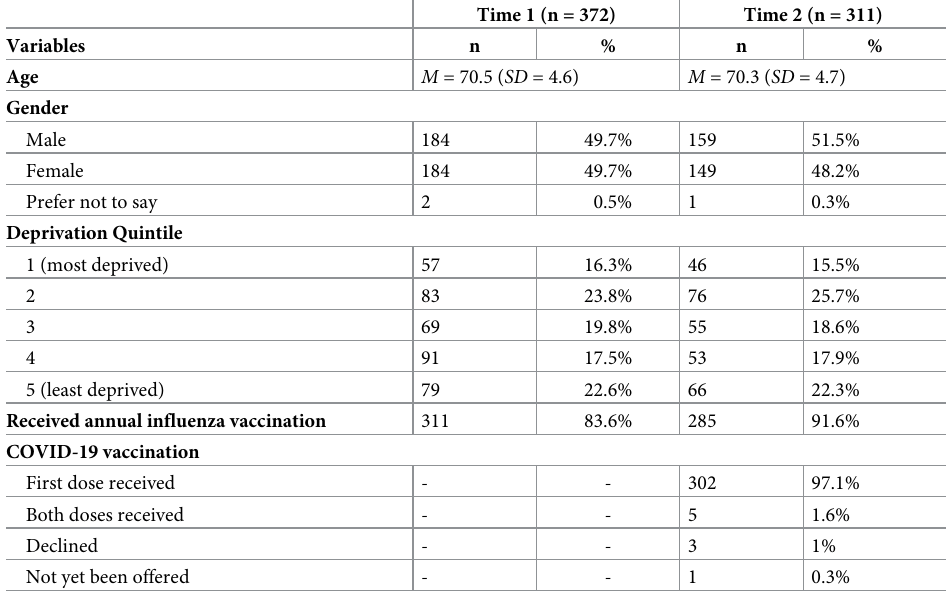
Table 1. Sociodemographic and vaccine uptake information for the sample at Time 1 and Time